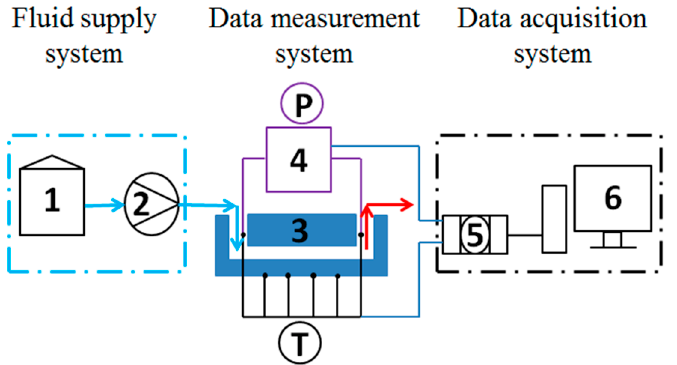
Figure 2. Schematic diagram of the experimental setup: (1) deionized water tank; (2) pump and flowmeter; (3) microchannel heat exchanger and film heater; (4) differential pressure transmitter; (5) data acquisition instruments; and (6) computer.